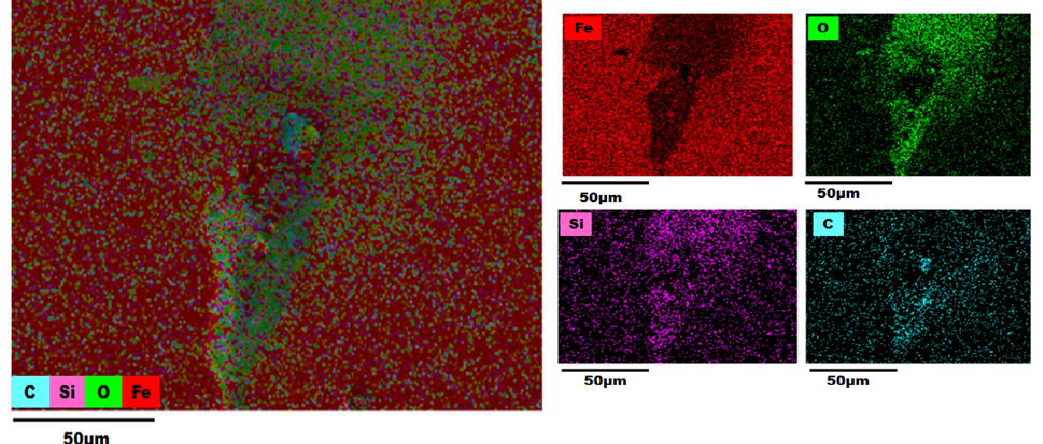
Figure 14. EDS map of a 90° elbow exit surface after the test for 5 wt.% sand fines concentration.